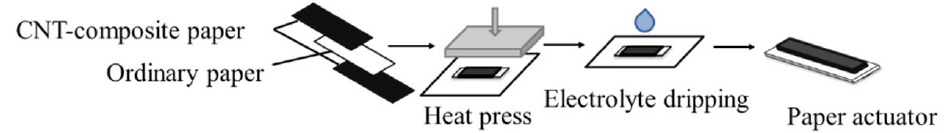
Figure 11. Process for making actuator.